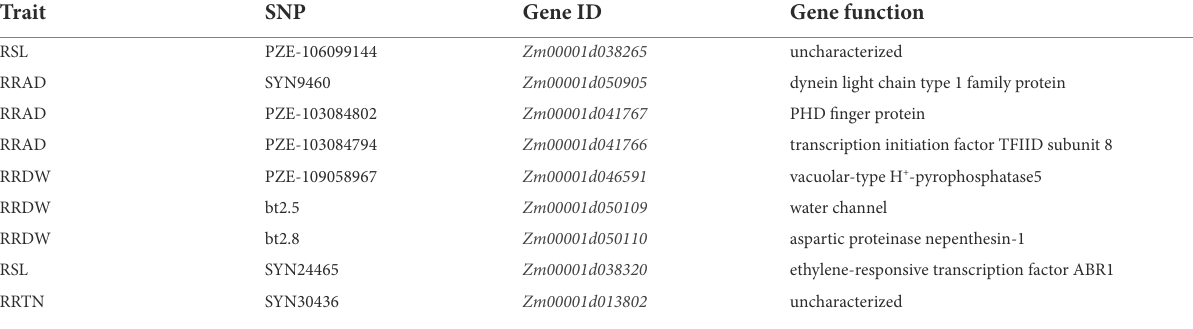
TABLE 3 Functions of candidate genes that are directly associated with alkaline tolerance